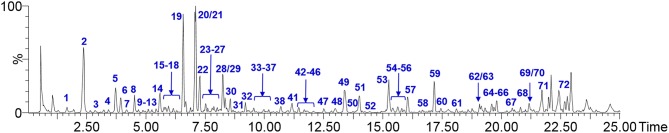
Base peak ion (BPI) chromatogram of JMT in negative scan.